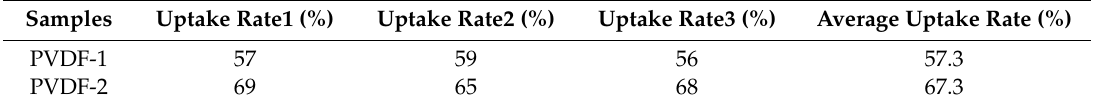
Table 1. The absorption performance of PVDF electrospun nanofiber membranes. Samples Uptake Rate1 (%)